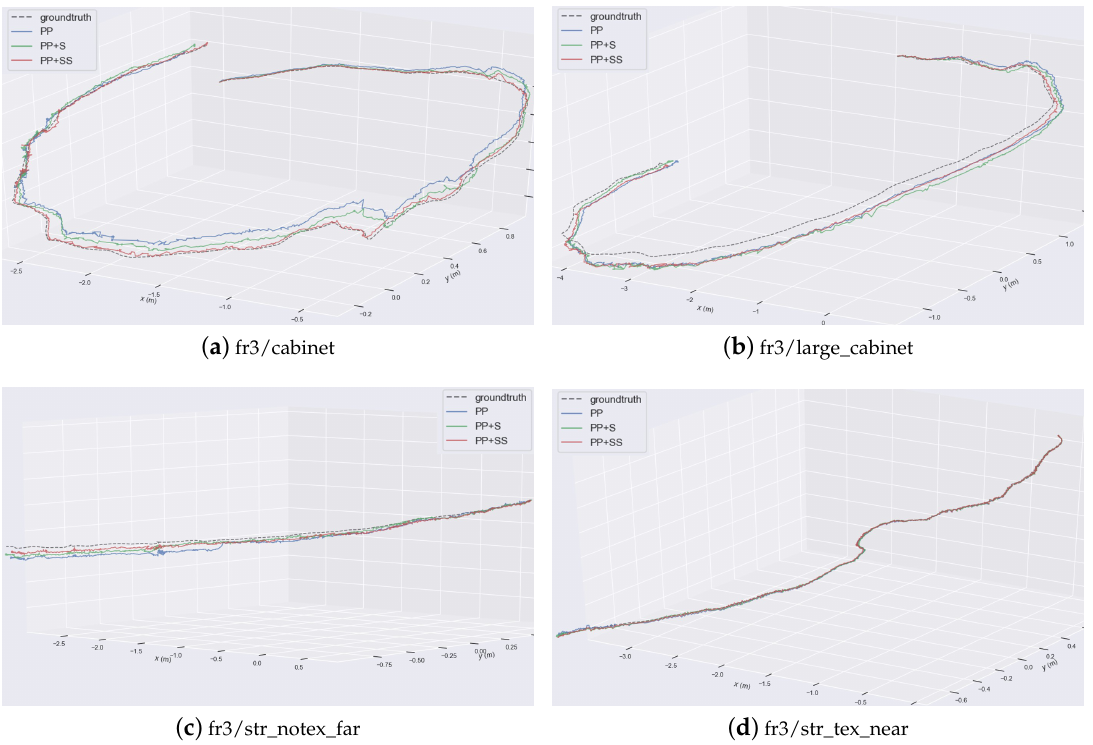
Figure 11. Comparison of estimated trajectories. Different trajectories are plotted